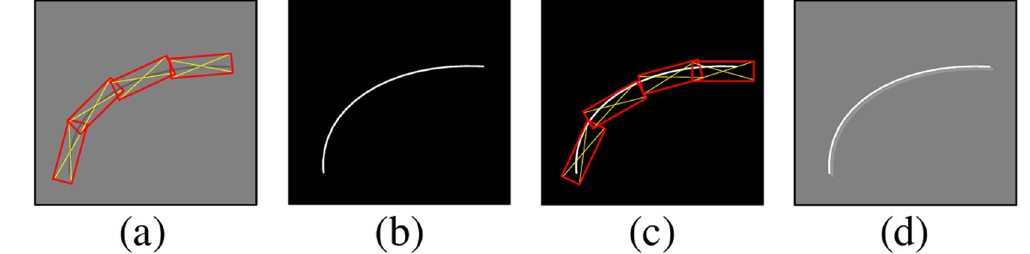
Figure 2. Illustration of halo artifacts by NSCT image enhancement. ( a ) Original image and NSCT forward transform; ( b ) enhanced transform coefficients; ( c ) NSCT inverse transform; and ( d ) enhanced image with halo